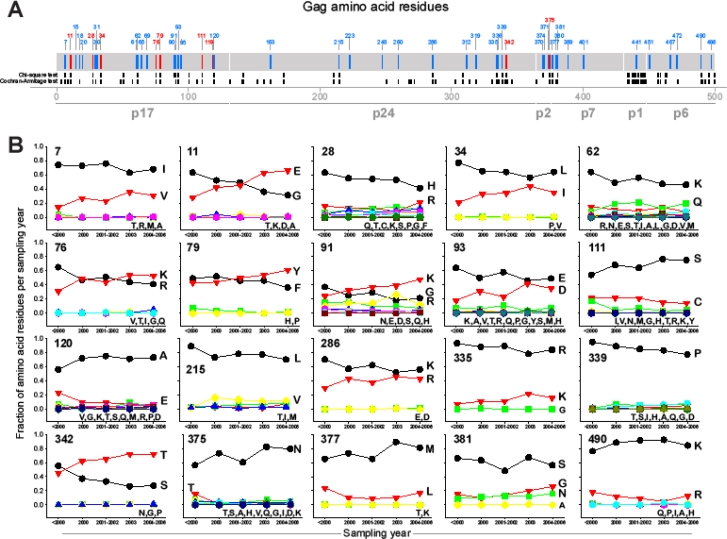
Changing amino acid residues in HIV-1 subtype C Gag. A: Overview of changing amino acid residues across Gag cleavage products. Location of changing amino acids is shown in relation to HXB2 numbering. Changing amino acid sites with frequency change of more than 20% are shown in red, and sites with frequency change between 10% and 20% are shown in blue. Location of changing amino acids detected by chi-square test and Cochran-Armitage trend test is depicted in black under the Gag bar. B: Dynamics of amino acid frequency at top 20 sites (significant changes by all three methods). Number in the upper left corner in each graph depicts location in relation to HXB2 numbering.